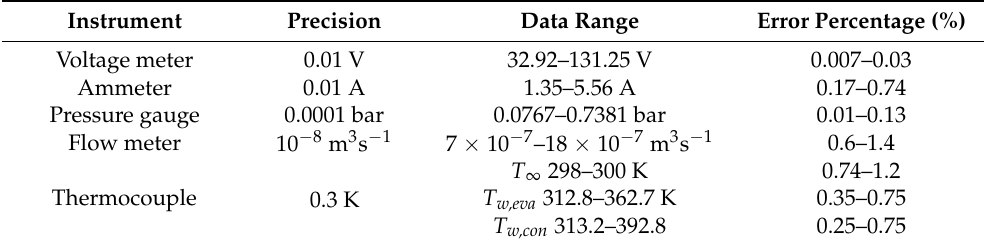
Table 1. Estimation of error percentages for the instruments measuring raw